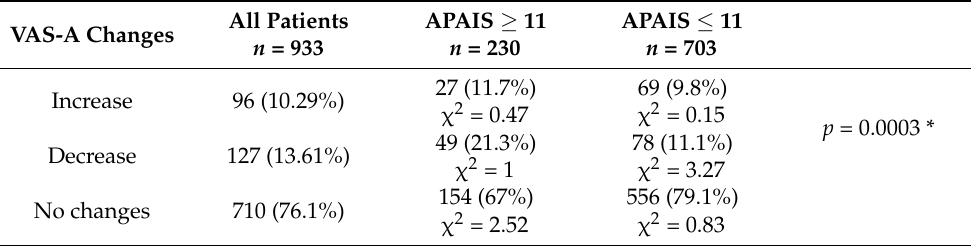
Table 3. Clinically relevant changes in anxiety level (>2 points) in patients during their stay in the